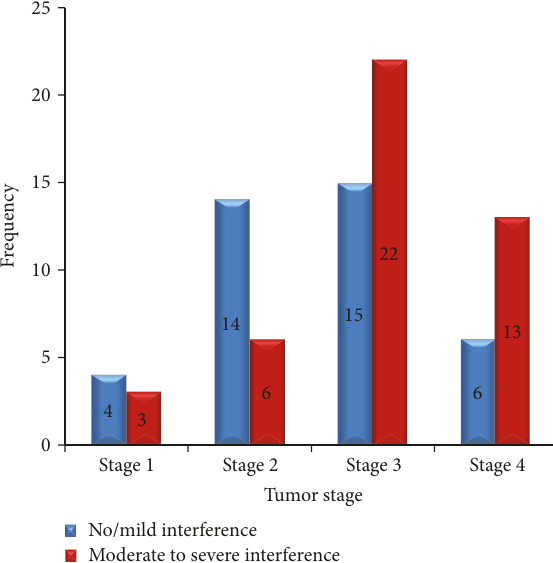
Figure 4: Frequency of pain interference severity within the stage of tumor, Gondar University Hospital, Gondar, Ethiopia.